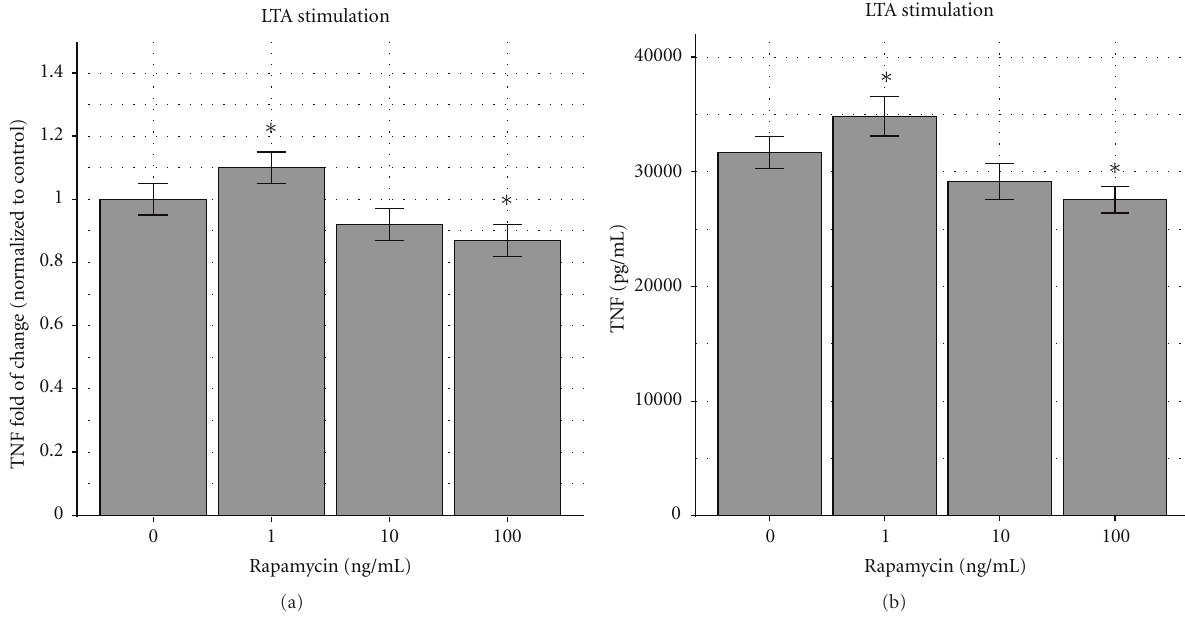
Figure 4: (a) E ff ects of rapamycin on RAW264.7 murine macrophages stimulated by LTA. Lipoteichoic acid (LTA) stimulated more TNF secretion by RAW264.7 murine macrophages when exposed to rapamycin at 0.1 and 1ng/mL and less when exposed to rapamycin at 100ng/mL. The response at 0.1ng/mL had an increase of 10%, significantly di ff erent ( P < 0 . 05) from the untreated control (first column). The response at 10ng/mL (third column) had a decrease of 8% (not significantly di ff erent), and the response at 100 ng/mL (fourth column) demonstrated a 13% decrease, significantly di ff erent from the control ( P < 0 . 05). The results are depicted as fold of change compared to the control with 95% confidence intervals shown as “error bars.” ∗ P < 0 . 05. The control response was 31,684 pg/mL ± 713 pg/mL. (b) E ff ects of rapamycin on RAW264.7 murine macrophages stimulated by LTA. Lipoteichoic acid (LTA) stimulated more TNF secretion by RAW264.7 murine macrophages when exposed to rapamycin at 0.1 and 1 ng/mL and less when exposed to rapamycin at 100ng/mL. (b) depicts (a) results with actual TNF (pg/mL) secretion, that is, 31.684(713), 34.852(889), 29149(809), and 27.565(593) pg/mL,